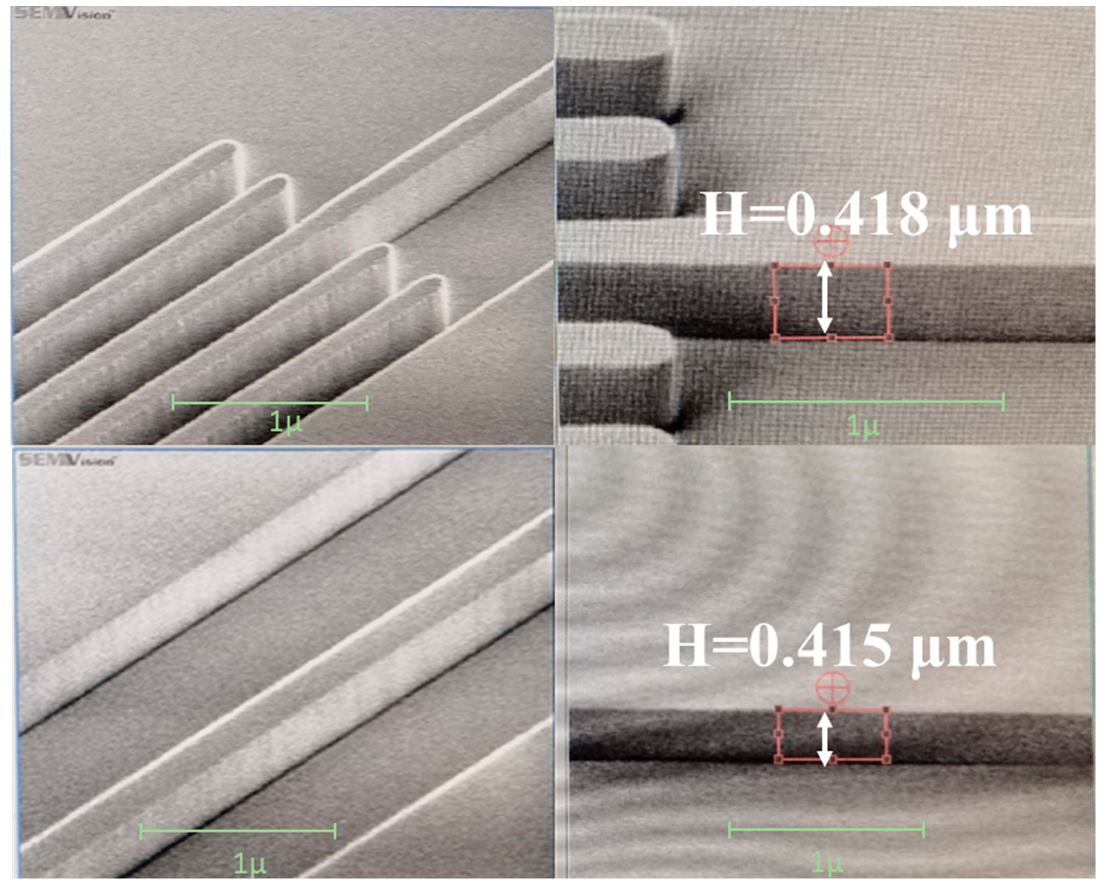
Figure 9. SEM images of the etched waveguide pa tt ern in the BOX.